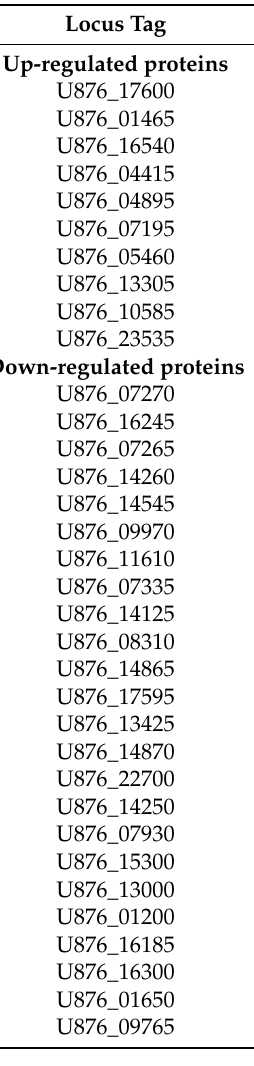
Table 2. Differentially expressed proteins in lahS mutant compared to the wild type strain. Locus Tag Predicted